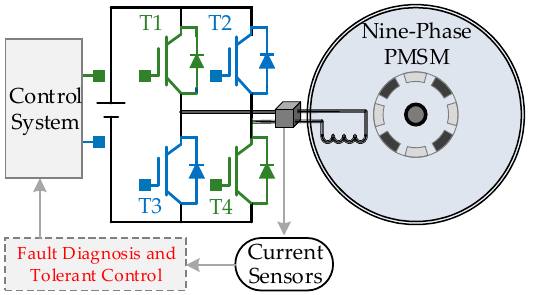
Figure 1. ( a ) Winding structure of nine-phase PMSM; ( b ) H-bridge drive topology. The probability of faults increases with the number of current sensors required for the nine-phase PMSM drives. The fault diagnosis and tolerant control of nine-phase PMSM drives are shown in Figure 2.